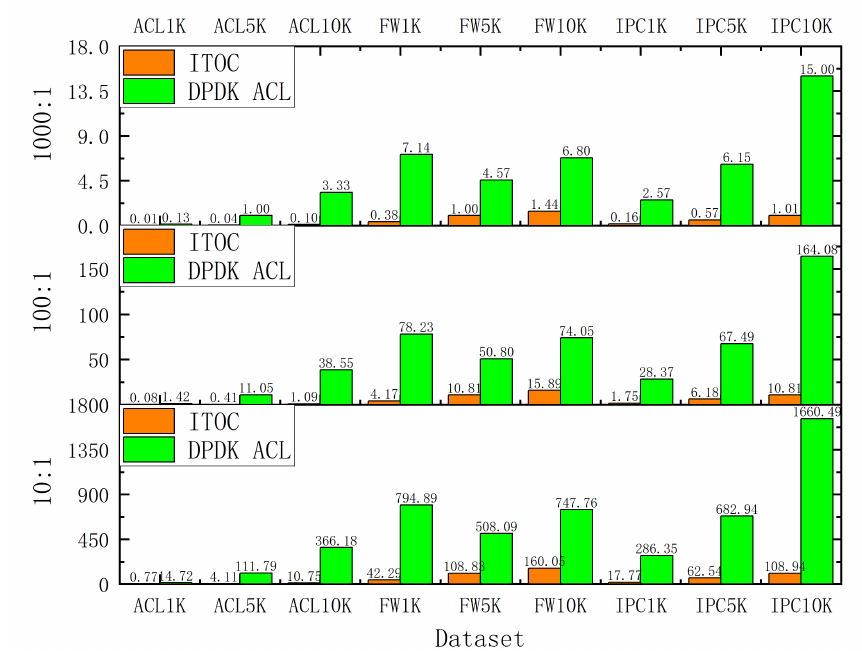
Figure 10. The mixed input processing time of ITOC and DPDK